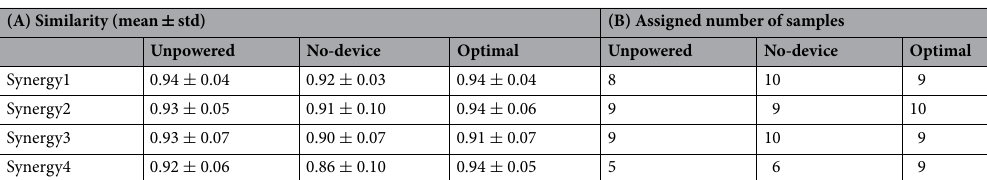
Table 1. (A) Similarity scores with the same synergies, in each condition. (B) The number of synergies assigned in each synergy group for a specific condition. The maximum sample number is 9, 10, and 10 for the unpowered, no-device, and optimal